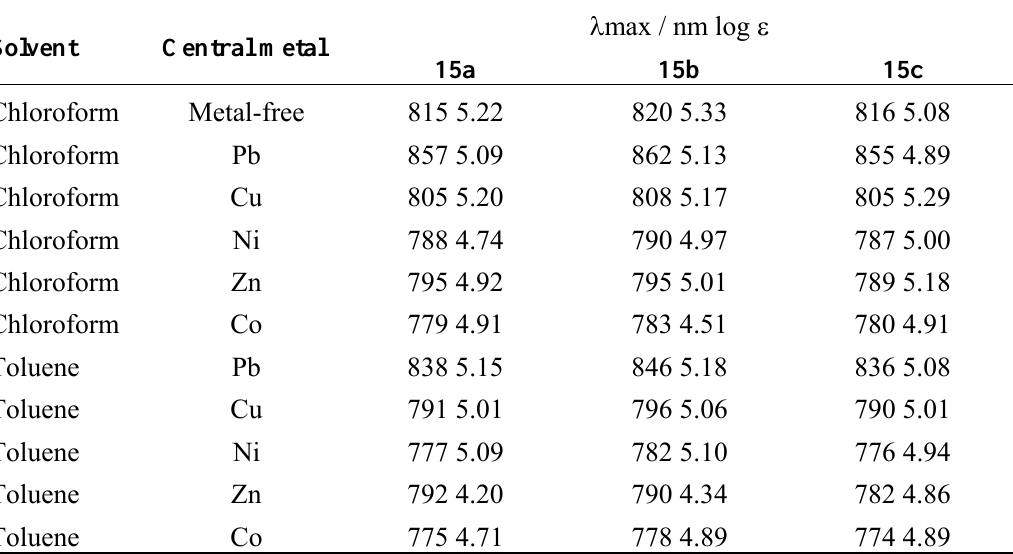
Table 13. The Q band absorption data of 15